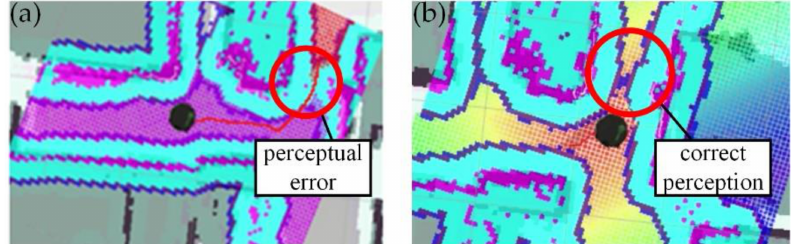
Figure 4. Navigation failure because of perceptual error: ( a ) The perceptual error in the door